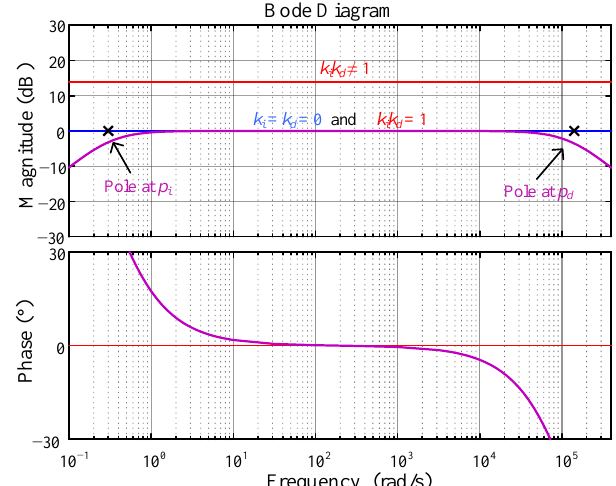
Figure 7. Results from the multiplication of pure and modified integral and derivative functions (blue—no gains | red—with gains | pink—with gains and added/displaced poles).